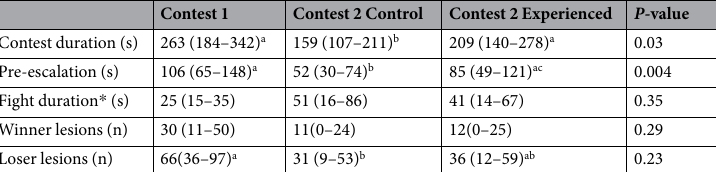
Table 3. Contest costs. Means with SE for the selected proxy measures of contests costs by treatment group. Values are back-transformed LSmeans with the lower and upper confidence intervals. * Only for contests including a fight; a,b Values lacking a common superscript letter differ by P <